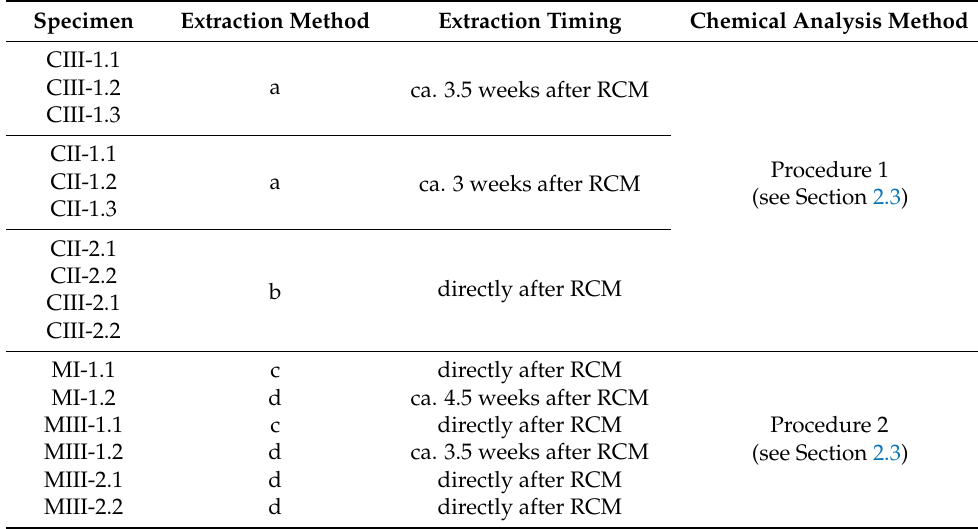
Table 2. Extraction method and timing as well as chemical analysis